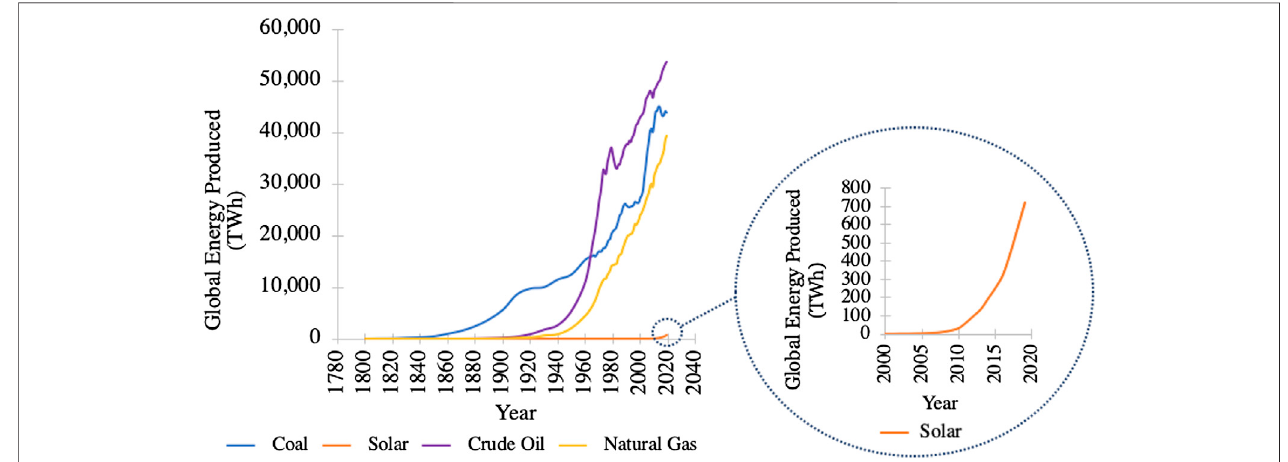
FIGURE 3 | A comparison of different forms of global energy produced in terms of TWh from 1800 to 2019. Values are obtained as CVS fi les from ourworldindata. org (Our World in Data, 2018).